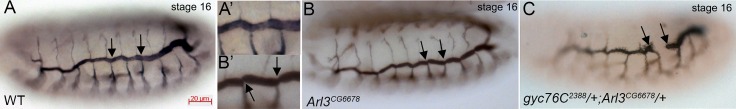
Arl3 genetically interacts with gyc76C to control DT lumen fusion.In wild-type embryos (A) the DT lumen is continuous by stage 16 (A and A’, arrows). In embryos homozygous for Arl3CG6678 (B) the DT lumen is constricted at sites of fusion (B and B’, arrows) and in embryos trans-heterozygous for gyc76C2388 and Arl3CG6678 (C) DT lumena failed to fuse (C, arrow). All embryos shown are at stage 16 and were stained for 2A12 and β-gal (not shown). Panels A’ and B’ are magnified views of regions in A and B marked by arrows.